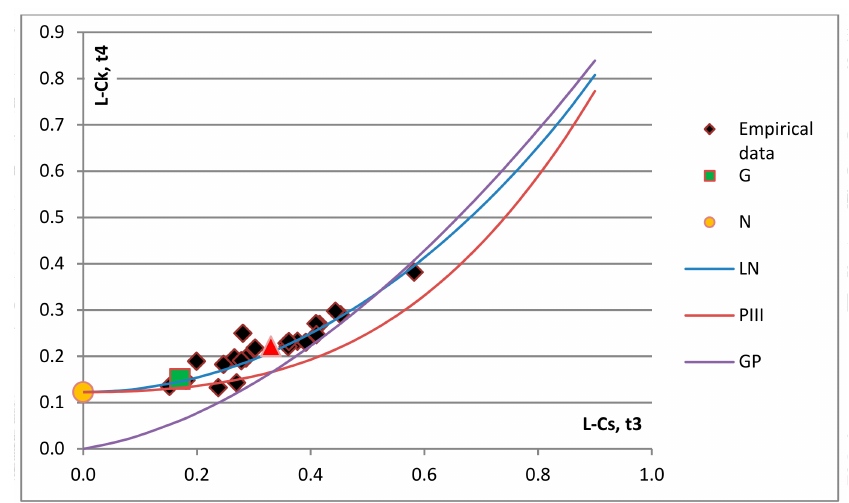
Figure 3. L-moments ratio diagram for duration of floods in the Pannonian basin.